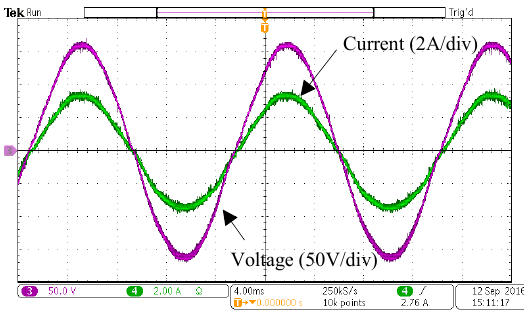
Fig. 17. Output voltage and output current when L g = 19.5 mH ( τ i =